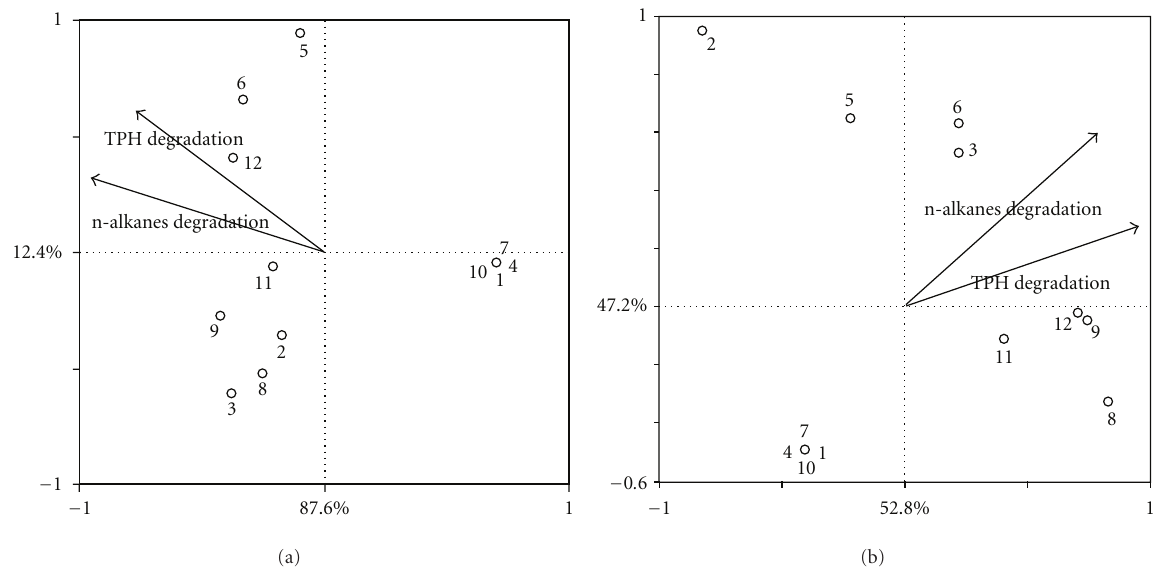
Figure 3: Ordination biplot displaying the first and second axis of a canonical correspondence analysis (CCA) using DGGE profiles (biological variables, open circles) and environmental variables (arrows) from Cantagalo (a) and Panelas (b) soil microcosms during bioremediation over time. (1) MNA T0, (2) MNA T60, (3) MNA T120, (4) MNAS T0, (5) MNAS T60, (6) MNAS T120, (7) BE/BA T0, (8) BE/BA T60, (9) BE/BA T120, (10) BES/BAS T0, (11) BES/BAS T60, and (12) BES/BAS T120.